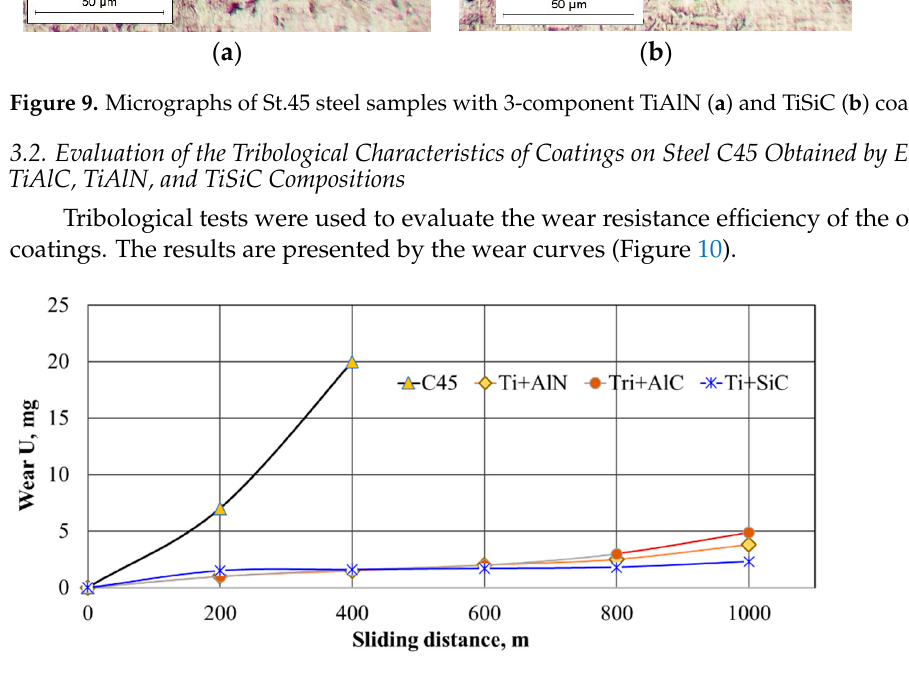
Figure 10. Coating wear at a specific load of 2 MPa.